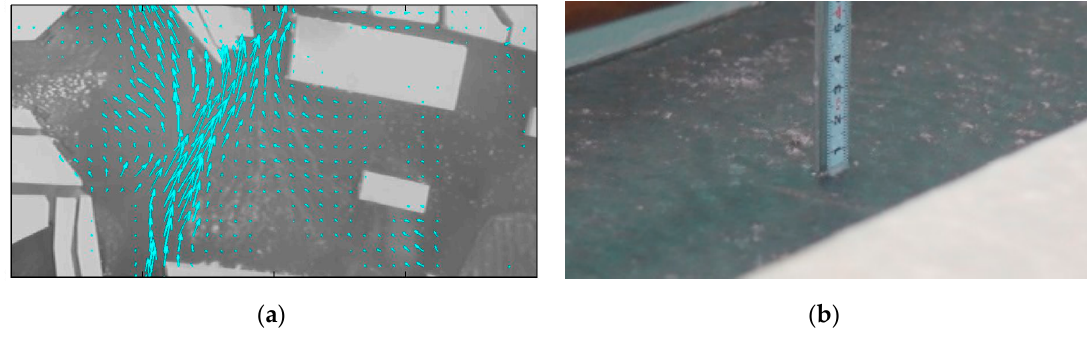
Figure 5. Flow measurements using Large-Scale Particle Image Velocimetry (LSPIV) and tape ruler: ( a ) runoff velocity measurement; ( b ) inundation depth measurement.